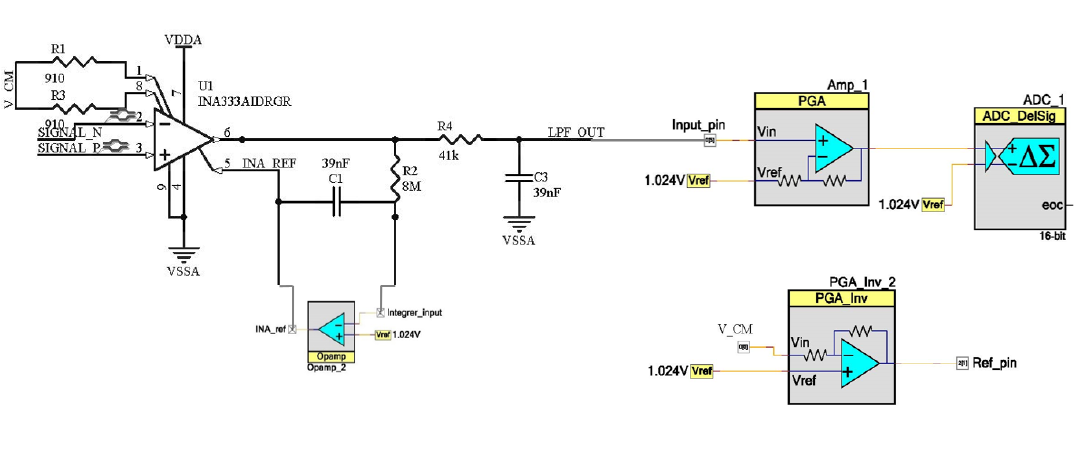
Figure 5. ECG acquisition